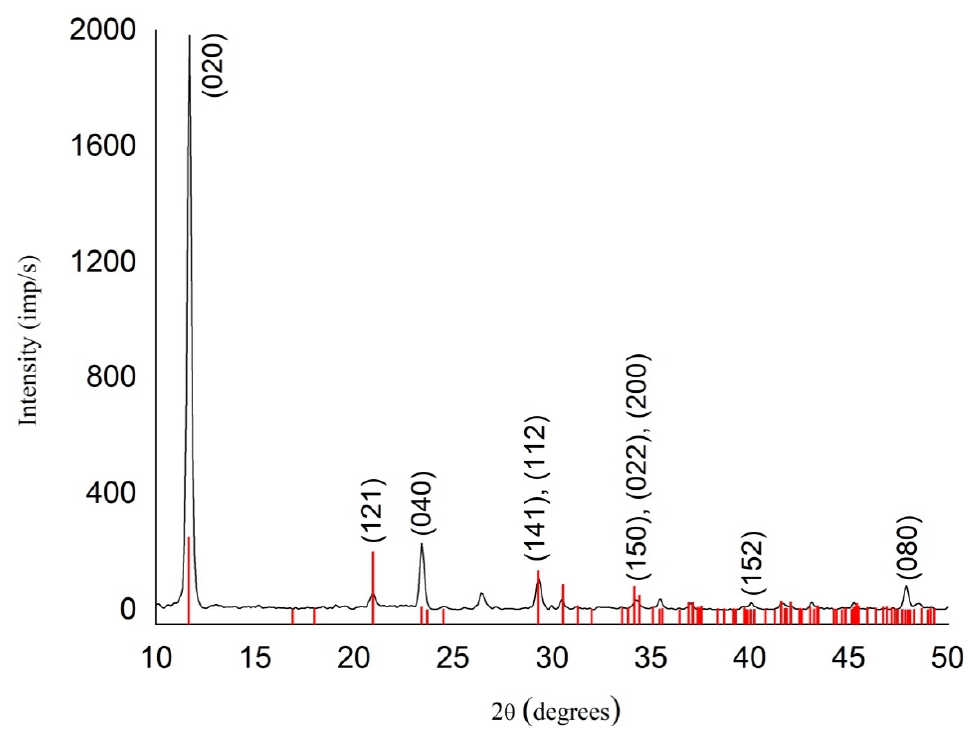
Figure 1. The X-ray diffraction pattern of calcium orthophosphate precipitated at pH 3.0, temperature 20 °C, and initial ratio Ca/P = 0.5. The diffraction pattern shifted 0.45 degrees left to match the reference data for dicalcium phosphate dihydrate (PCPDFWIN (PCPDFWIN, Newtown Square, PA, USA) No. 72-0713), which are shown in the figure with the red lines. The additional reflex at 26.4 degrees can be described as an impurity element of dicalcium phosphate anhydrous CaHPO 4 (No. 77-0128).